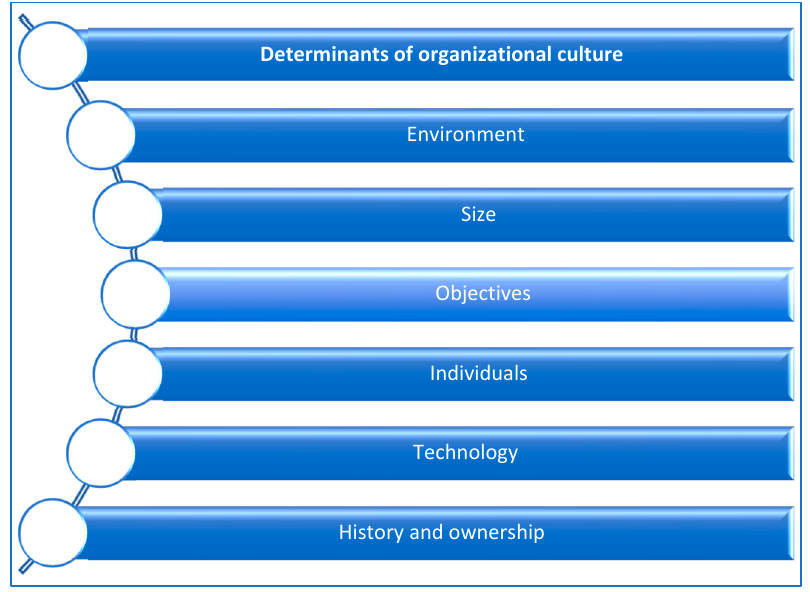
Figure 2. Determinants of organizational culture. Figure created by the author.